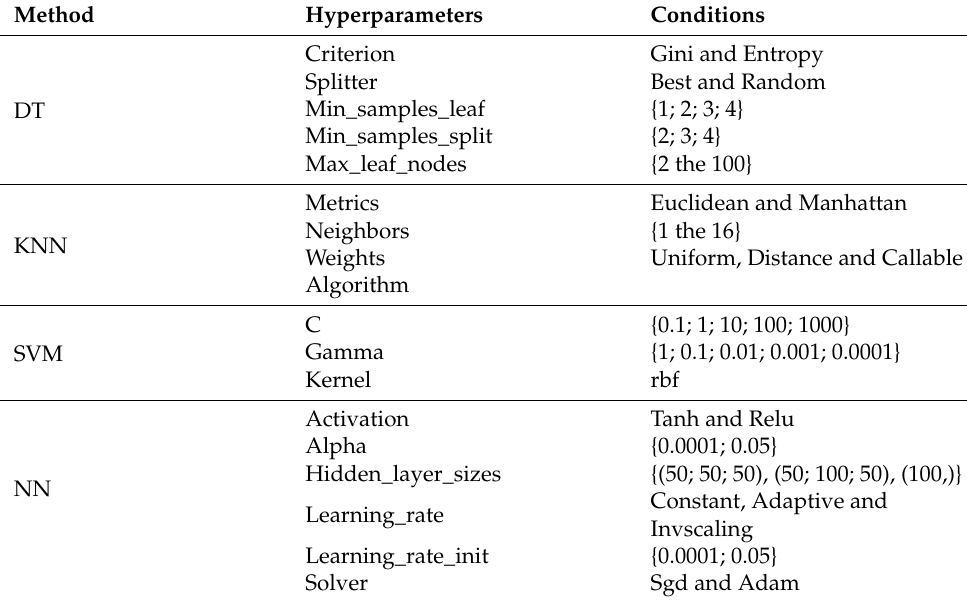
Table 3. Hyperparameters of each model based on the scikit learn